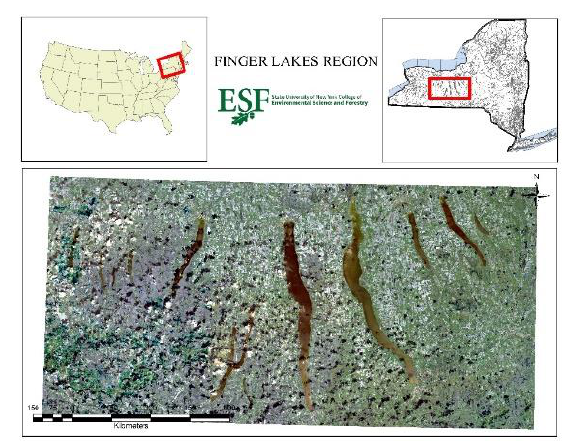
Figure 1: Study Area Showing Finger